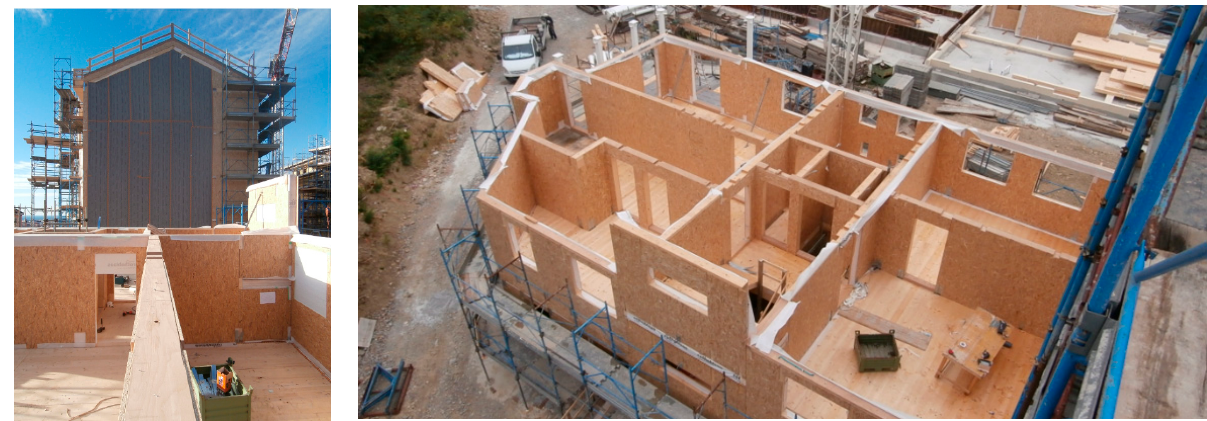
Figure 1. Realization of the test-building.